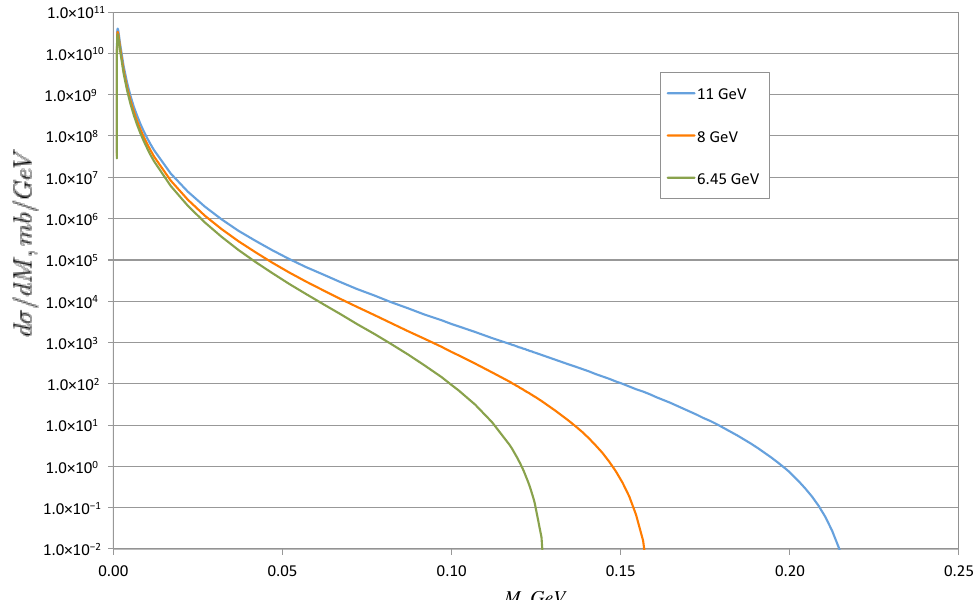
Figure 1. The distribution of masses of dielectrons produced in ultraperipheral collisions at NICA √ s nn = 11 GeV ( blue , upper), 8 GeV ( red , middle), 6.45 GeV ( green , energies